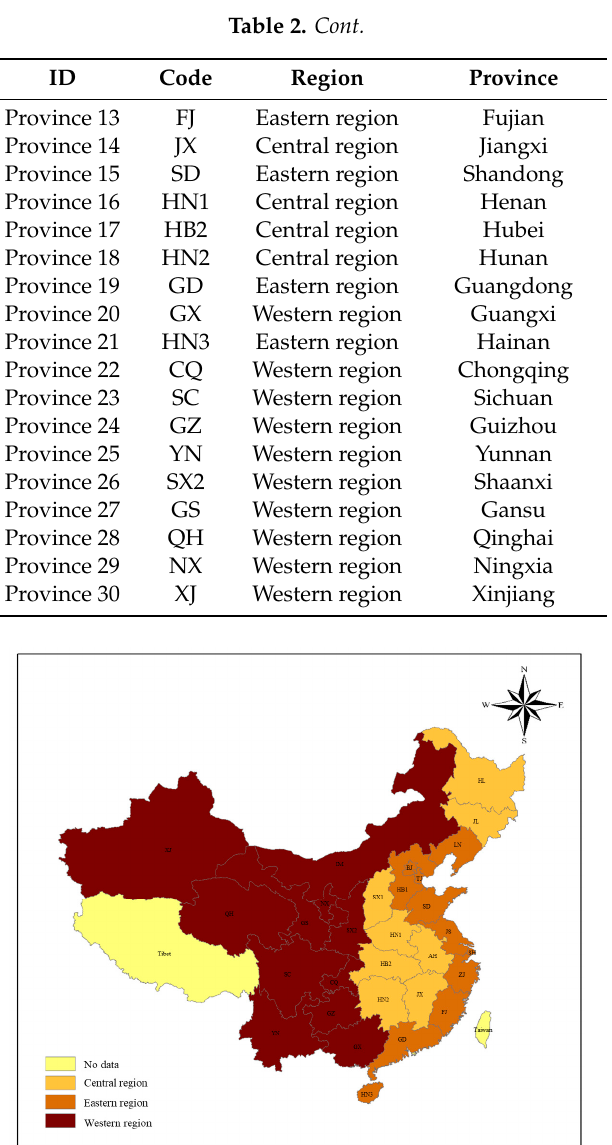
Figure 2. Map of di ff erent regions, except the South China Sea Figure 2. Map of different regions, except the South China Sea islands.